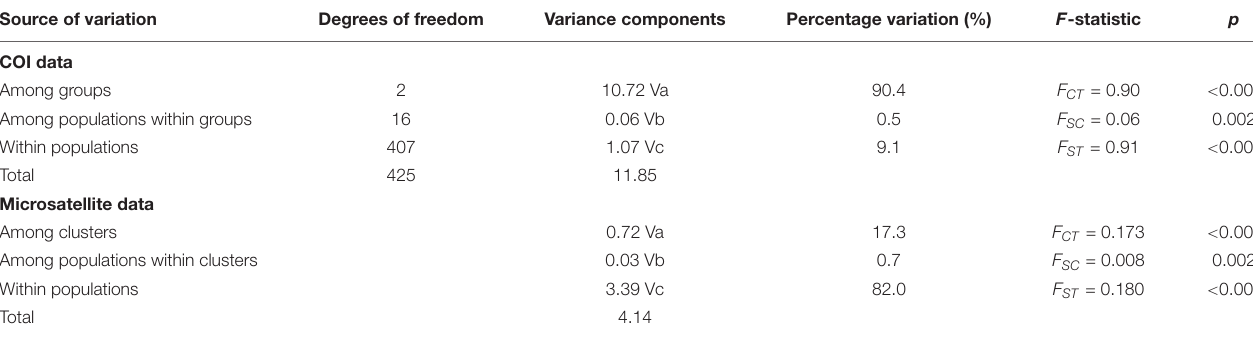
TABLE 1 | Results of AMOVA of mtDNA cytochrome oxidase subunit I (COI) and microsatellite data from 19 Parantica sita